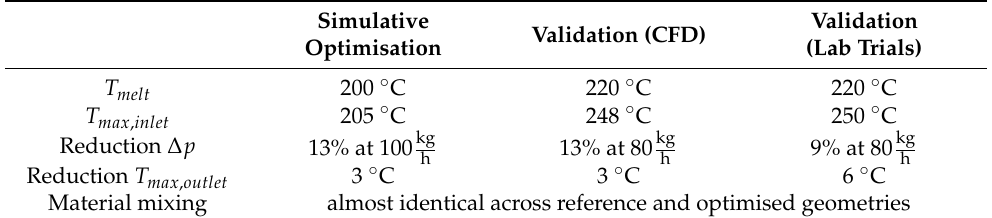
Table 2. Comparison between the results obtained by simulation and lab trials. Changes labeled as Reduction refer to the change with respect to their counterpart before the numerical optimisation.